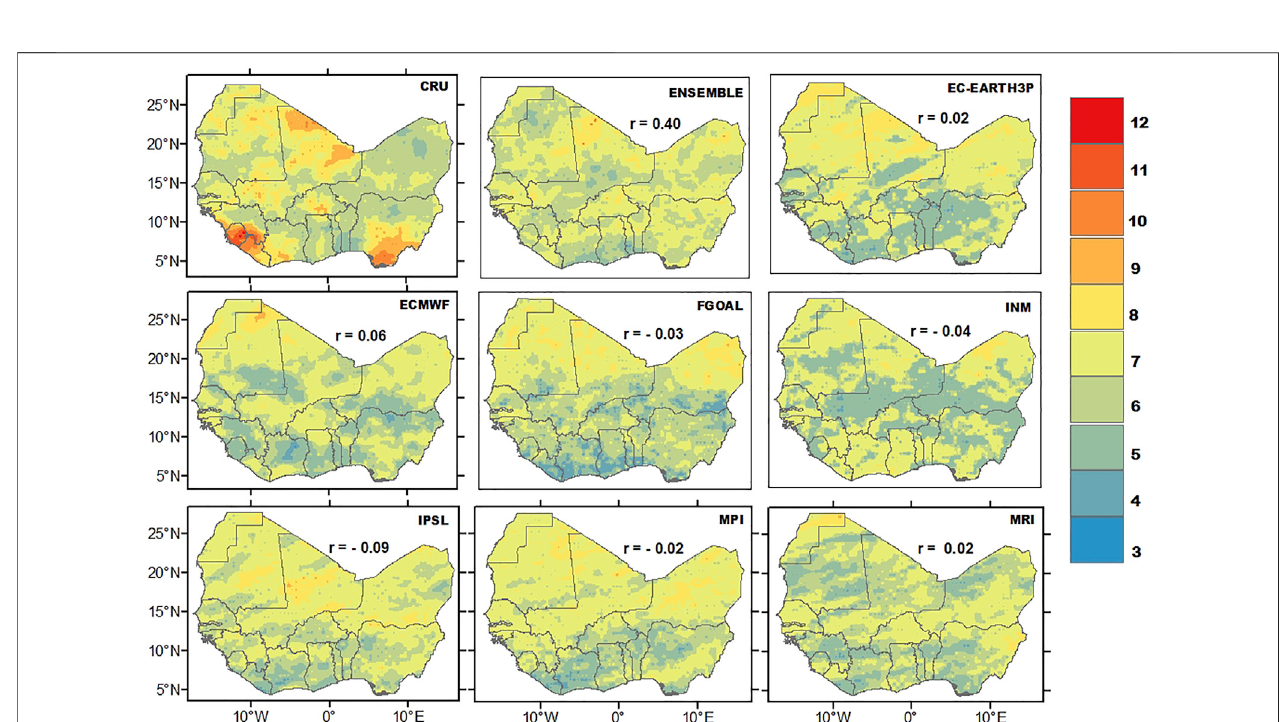
FIGURE 11 | Observed and simulated distribution of frequencies of severe meteorological drought (SPEI-1) over West Africa during1985 – 2014. r indicates the Pearson pattern correlation between the CRU and each HighResMIP simulation.